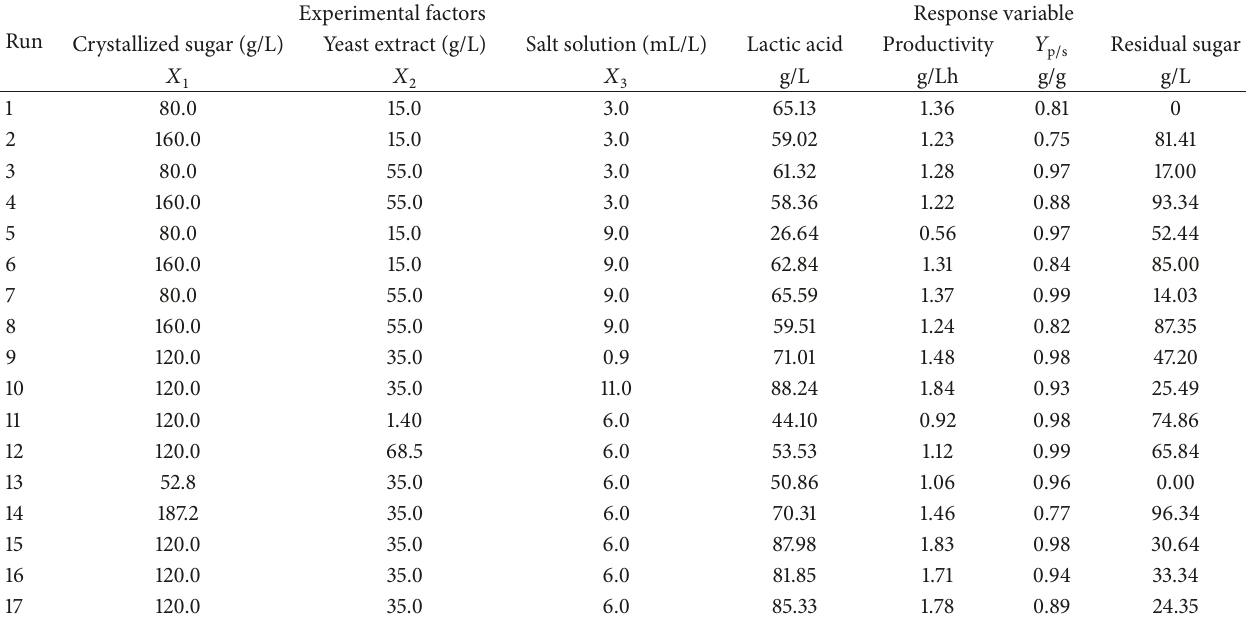
Table2:RSMdesignwithrealvaluesandexperimentalresultsforlacticacidproduction,productivity,yield,andresidualsugarconcentration.